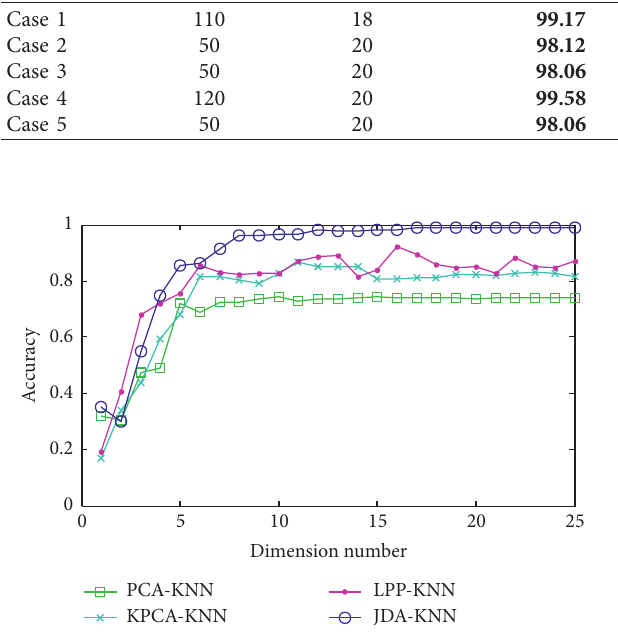
Figure 14: Diagnosis results of Case 5 by using PCA, KPCA, LPP, and JDA under different dimension